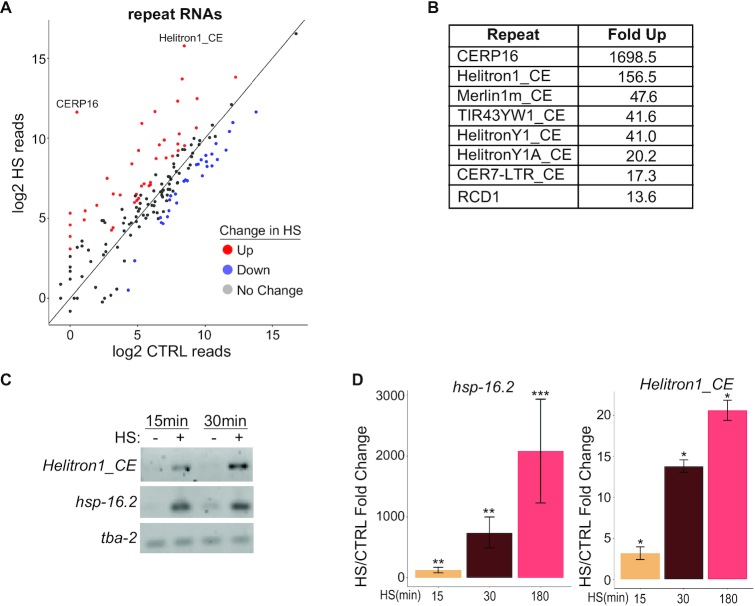
Upregulation of multiple repetitive element RNAs during HS. (A) Expression of repetitive element RNAs in CTRL versus HS detected by stranded paired-end sequencing and mapped to a database of repetitive elements (24). Significantly up- (red) and downregulated (blue) repeat RNAs (≥2-fold change with baseMean ≥ 100 and padj < 0.05 from three independent replicates) are indicated. (B) List of repetitive element RNAs upregulated at least 10-fold in HS. (C) Semi-quantitative RT-PCR detection of the indicated RNAs in CTRL and after 15 or 30 min of HS. (D) Quantitative RT-PCR analysis of hsp-16.2 and Helitron1_CE RNA expression during a time course of HS. Mean fold changes and SEM from three independent replicates are shown. *P < 0.05, **P < 0.01, ***P < 0.001 (t-test, two-sided).